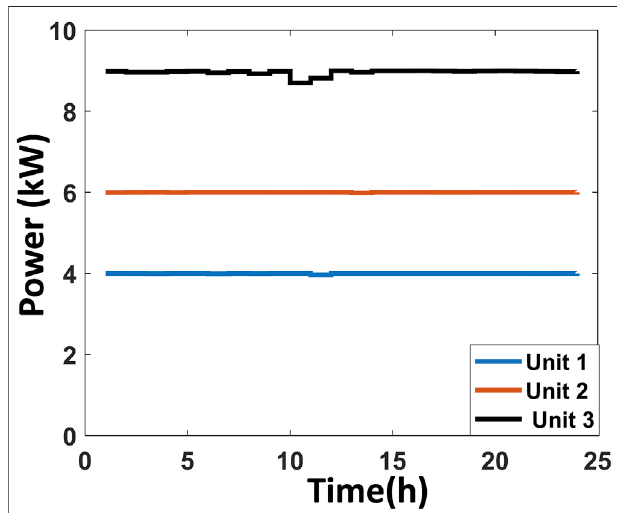
FIGURE 4 | Convergence characteristic curve of all studied techniques for Case 1.